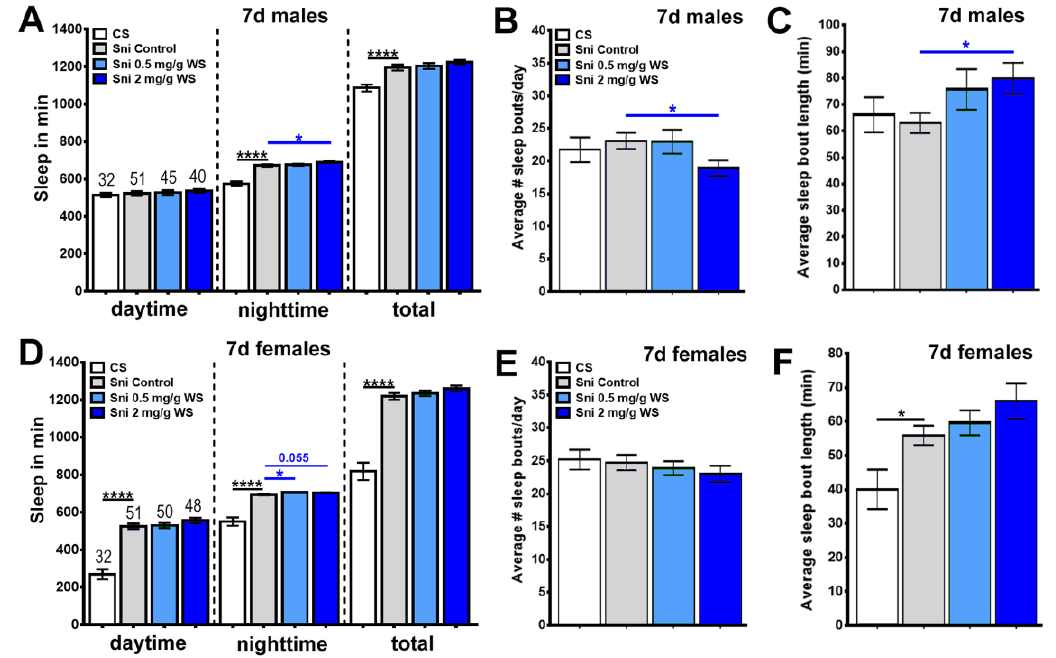
Figure 7. Average number of time asleep, sleep bouts per day and sleep bout length for sniffer flies treated with WS (0.5 mg/g and 2 mg/g). Drosophila melanogaster sniffer males ( A – C ) and females ( D – F ) were fed standard food or standard food supplemented with WS (0.5 mg/g or 2 mg/g) for 7 days. Flies aged 8 days were placed in the activity monitor for 9 days. Locomotor activity was analyzed once every minute for 7 days of light/dark (12 h:12 h LD). ( A , D ) Average time spent asleep during 12h daytime, 12h nighttime, and an entire 24h day. ( B , E ) Number of sleep bouts during a day. A sleep bout was regarded as a period of 5-min or more with no activity. ( C , F ) Average length of sleep bouts. The number of flies tested is indicated above the bars. Error bars represent SEM. * = p < 0.05, **** = p < 0.0001 compared to untreated sniffer flies (Sni control).